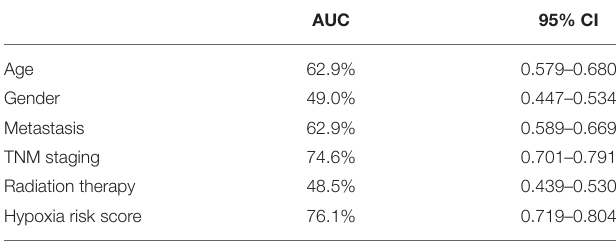
TABLE 1 | The predictive accuracy of the hypoxia-related risk model and other clinical characteristics.